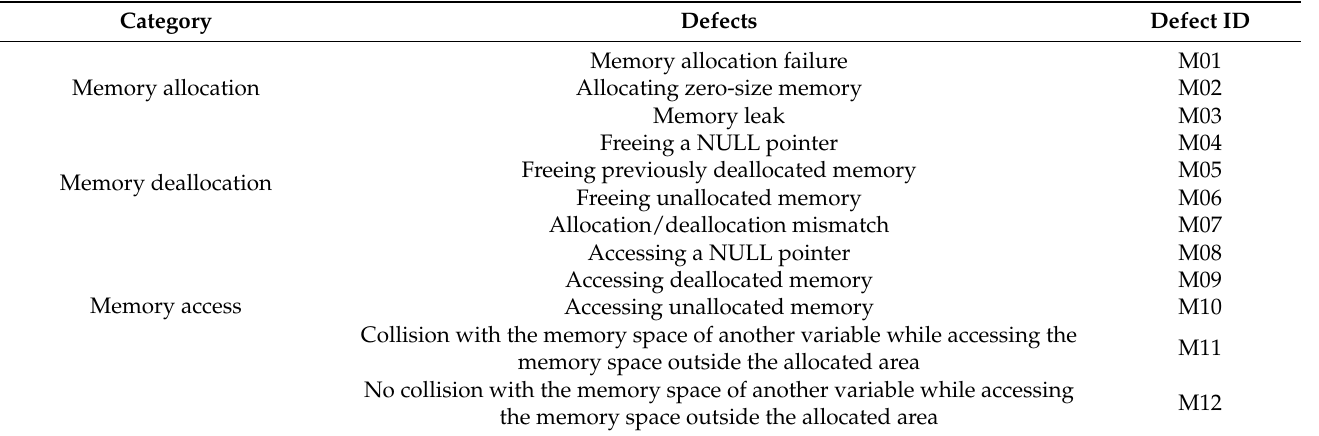
Table 1. Memory defect categories.